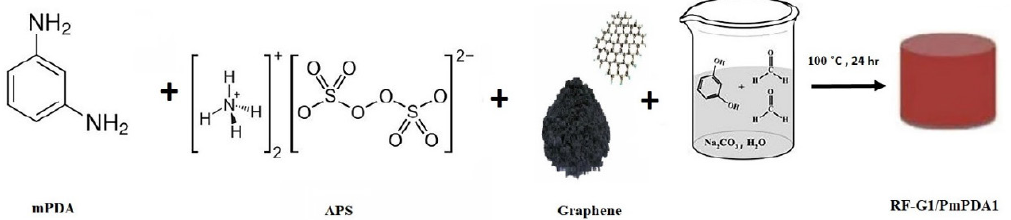
Fig. 1. Schematic of the synthesis process of RF-G1/PmPDA1